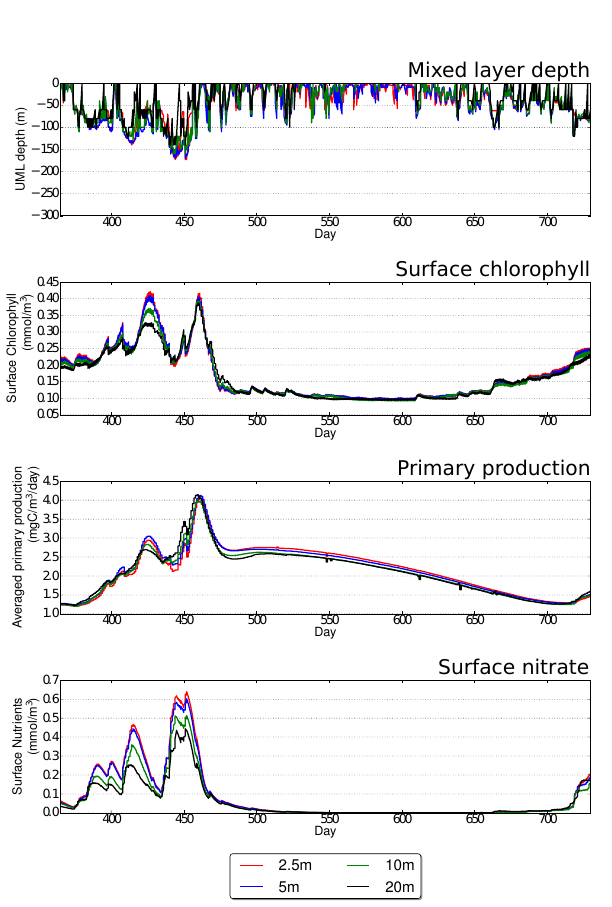
Fig. 8. Summary of simulated physical and biological behaviour at Station India using uniform meshes at a number of resolutions. From top to bottom, panels show MLD, surface chlorophyll, inte- grated primary productivity and surface